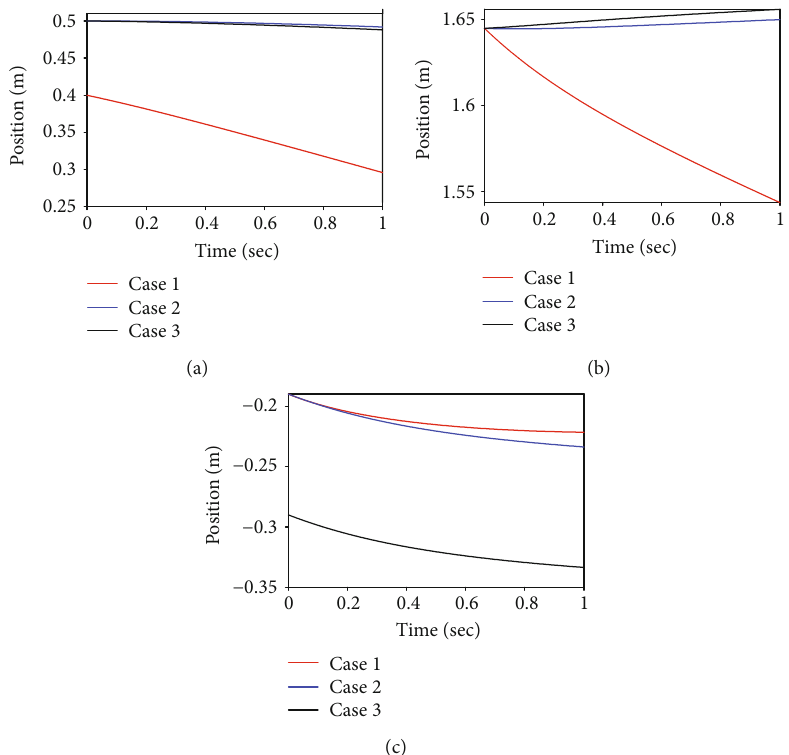
Figure 20: Position of the point O